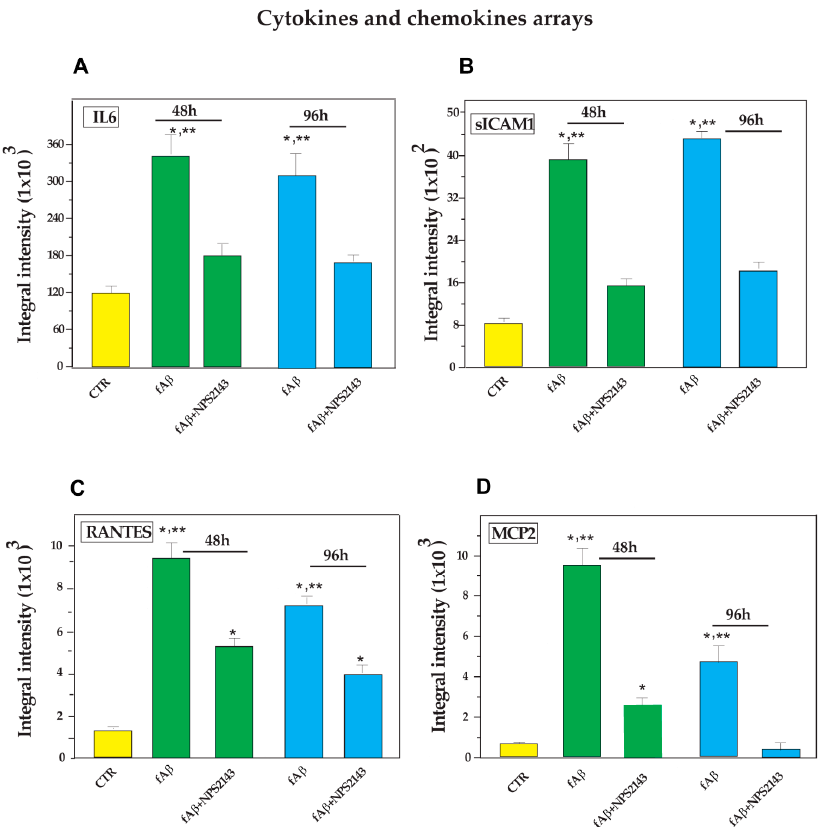
Figure 2. Time-dependent differential expression of ( A ) Interleukin (IL)-6, ( B ) Soluble intercellular adhesion molecule-1 (s-ICAM-1), ( C ) Regulated upon Activation, normal T cell Expressed and presumably Secreted (RANTES), and ( D ) Monocyte chemoattractant protein (MCP)-2, the basal secretion of which increased after treating NAHAs with fA β 25–35 , yet significantly decreased after fA β 25–35 + NPS 2143 treatment. Each neuroinflammatory agent was detected in the NAHA-conditioned media via membrane-based antibody arrays as described in the Materials and Methods. The developed antibody arrays were analyzed in an Odissey TM (LI-COR) scanner and the positive staining intensities of IL-6, s-ICAM-1, RANTES, and MCP-2 were quantified using the Image Studio TM (version 5.2) software. The integral intensities of the positive signals from each array were normalized via comparisons to corresponding controls. Bars are means ± SEMs of three independent experiments, each carried out in duplicate. One-way ANOVA followed by post hoc Tukey’s test allowed to calculate P values. CTR, untreated controls. * P < 0.05 vs. CTR; ** P < 0.05 of fA β 25–35 alone vs. fA β 25–35 + NPS 2143 treatment. Conversely, both at 48 h and 96-h, fA β 25-35 alone treatment did not change ( P > 0.05 vs. controls) the basal secreted amounts of MCP-1, and TIMP-2 (v. Figure S1). In summary, the antibody array results allowed us to distinguish three secretion patterns of the neuroinflammatory agents into the media from fA β 25–35 ± NPS 2143-treated NAHAs: (i) a significant increase elicited by fA β 25–35 treatment, which fA β 25–35 + NPS 2143 cotreatment brought back to control levels by 96 h as was typical of IL-6, MCP-2, and soluble (s)-ICAM-1 fragment, whereas it only partially reduced RANTES secreted levels (Figure 2);